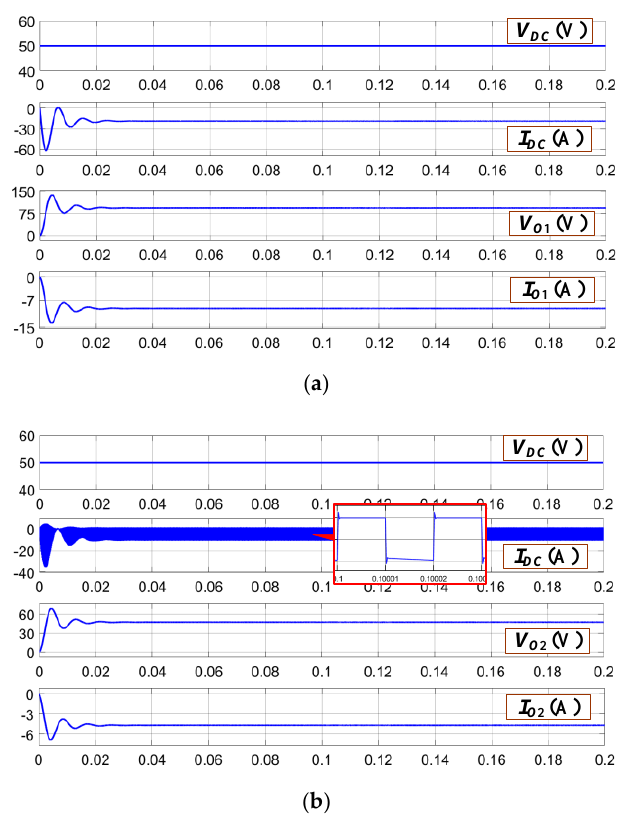
Figure 11. Simulation results of ( a ) The charging scenario A; ( b ) The charging scenario B.